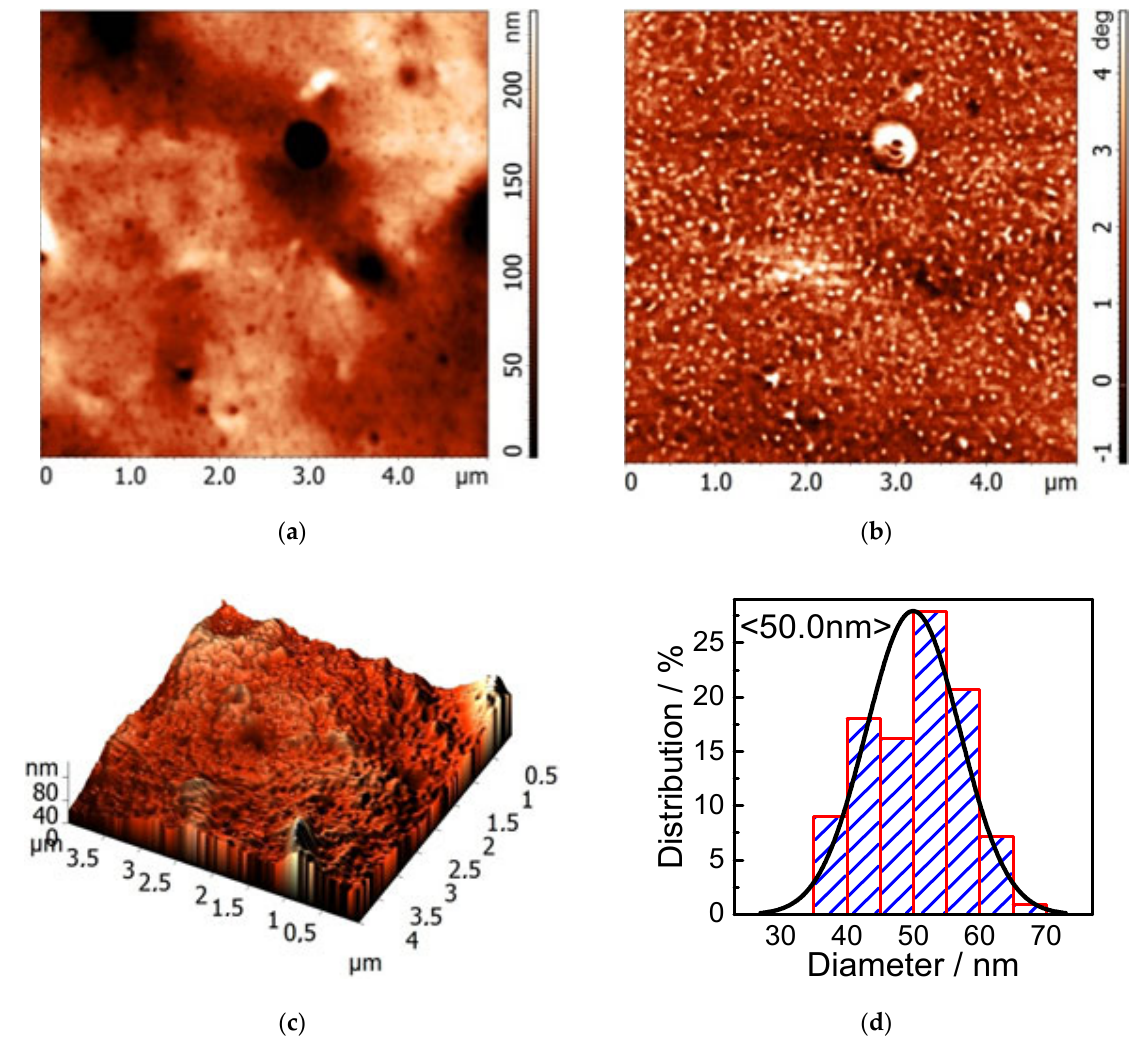
Figure 6. Atomic force microscopy data: ( a ) relief, ( b ) phase contrast, ( c ) 3D relief, and ( d ) particle size distribution diagram.